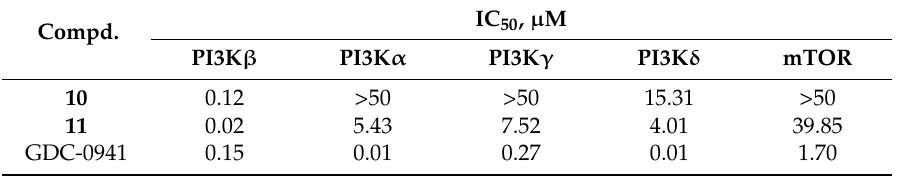
subunit; mTOR: Mammalian target of rapamycin.